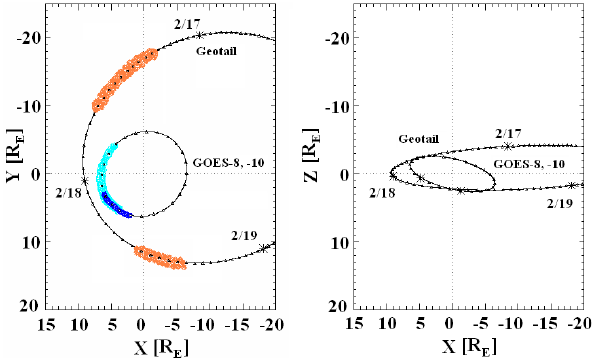
Fig. 4. The orbits of Geotail, GOES-8 and GOES-10 are plotted on the X-Y (left) and X-Z (right) planes in GSE coordinates for the pe- riod from 17 to 19 February 2001. The asterisks and triangles mark the location of the satellites at 00:00 UT and at every hour in UT, respectively. The orange-shaded areas indicate the regions where Geotail observes intense ULF fluctuations; the overlapping regions marked in blue and cyan mark the regions where narrow band fluc- tuations are recorded by GOES-8 and GOES-10 respectively on 17 and 18